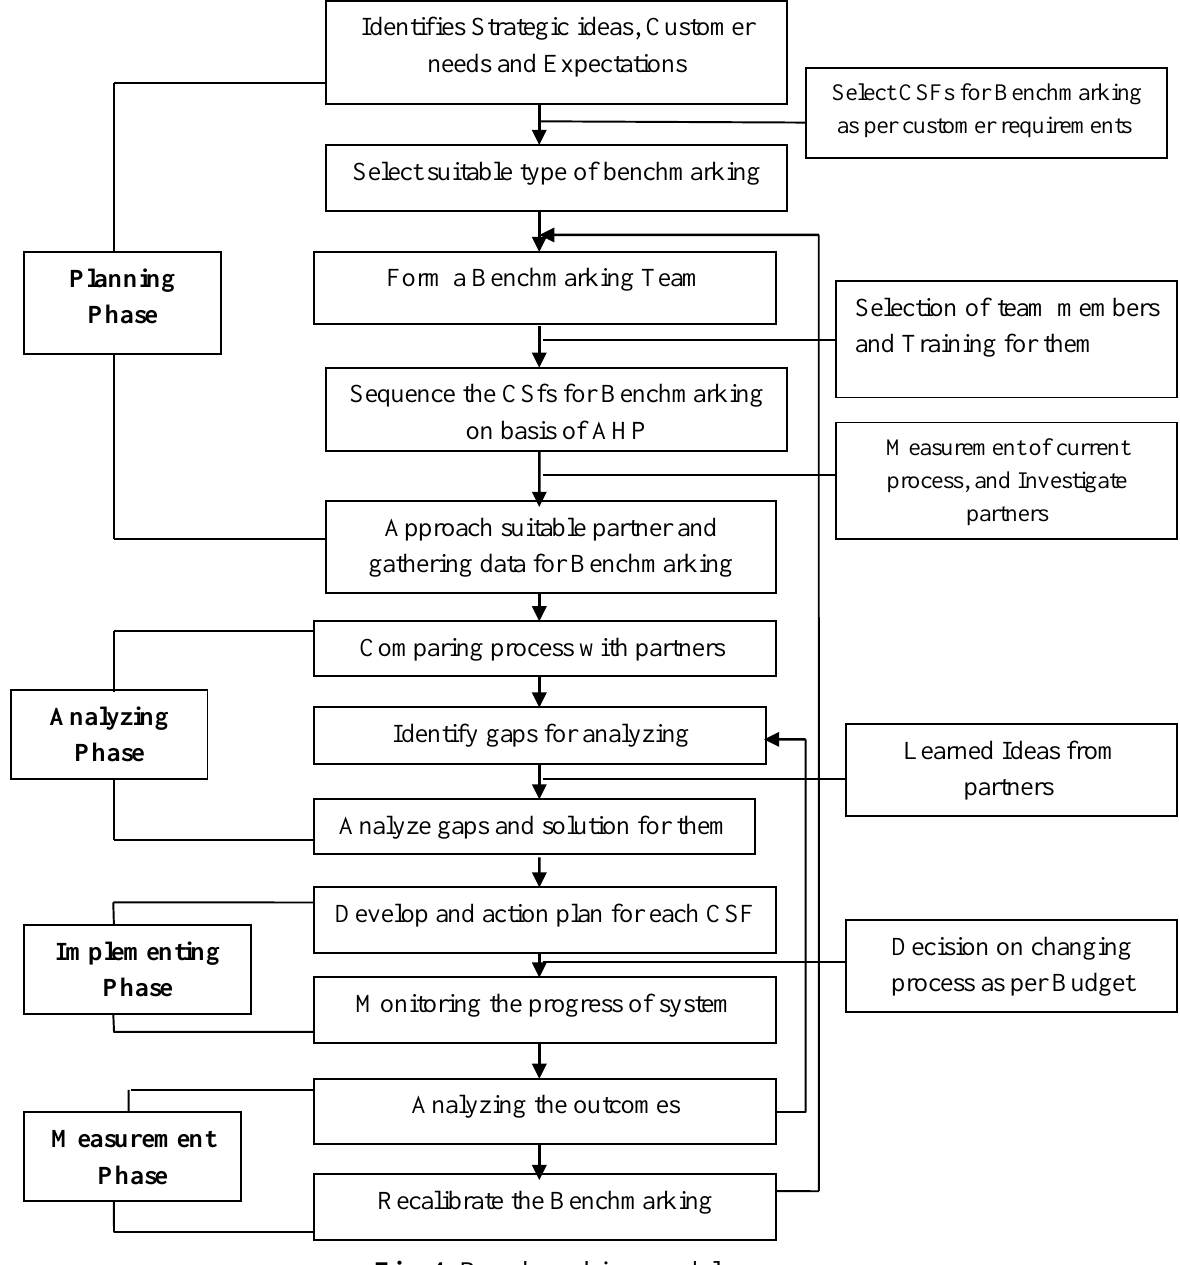
Fig. 4. Benchmarking